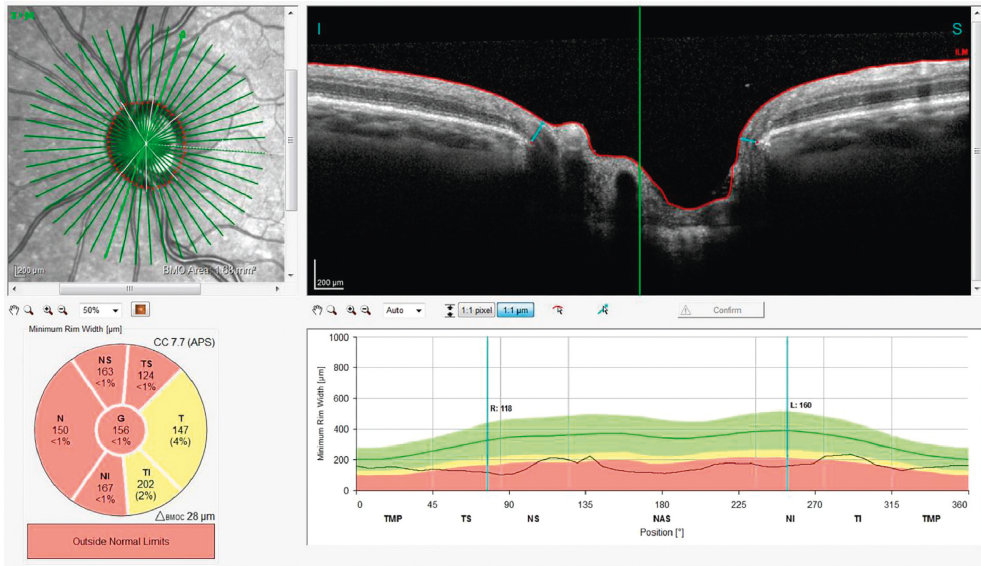
Figure 3: Bruch’s membrane opening minimum rim width analysis.